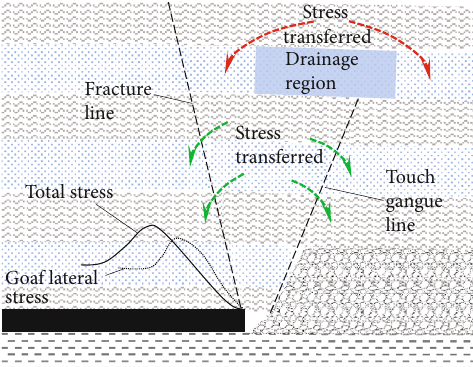
Figure 7: Stress evolution of roadway along goaf located in drainage pressurization